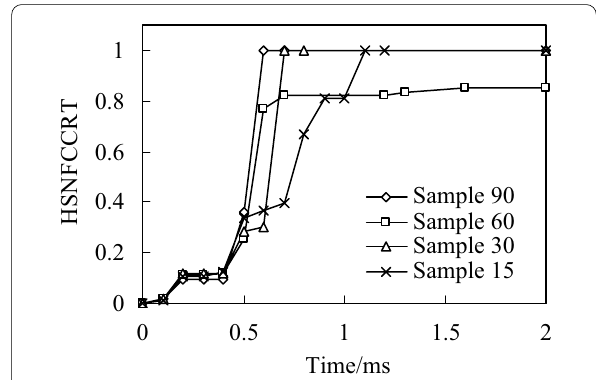
Fig. 4 Relationship of fiber compression failure and impact time